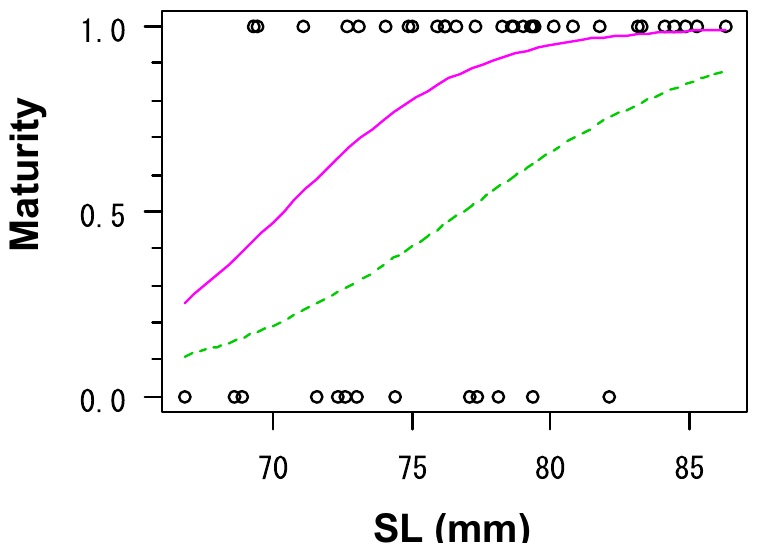
Fig 3. Relationship between standard length (SL) and the maturity of western sand lance ( Ammodytes japonicus ) in the low ration treatment in Experiment II. Specimens collected on December 12, 26, and January 11 were used. Binomial maturity (mature = 1, immature = 0) assigned to each individual was plotted. The green dashed line represents the generalized linear model (GLM; logit [Maturity] = 0.21 × SL– 16.12) fitted to the data of December 12. The purple solid line represents the GLM (logit [Maturity] = 0.30 × SL– 21.21) fitted to the pooled data of December 26 and January